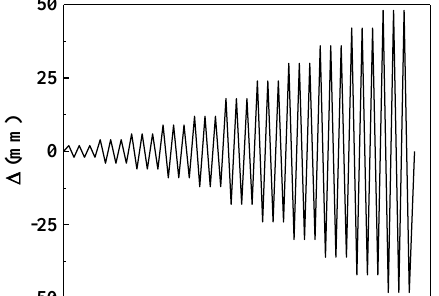
Figure 15. Loading procedure for the low cyclic loading test.